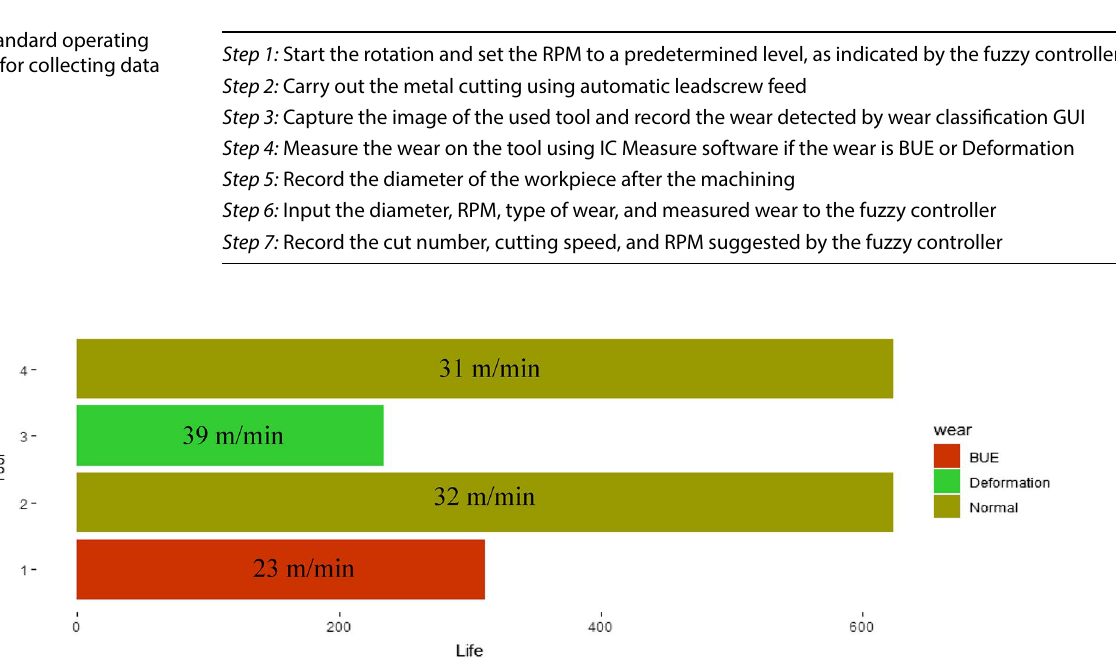
Table 7 Standard operating procedure for collecting data